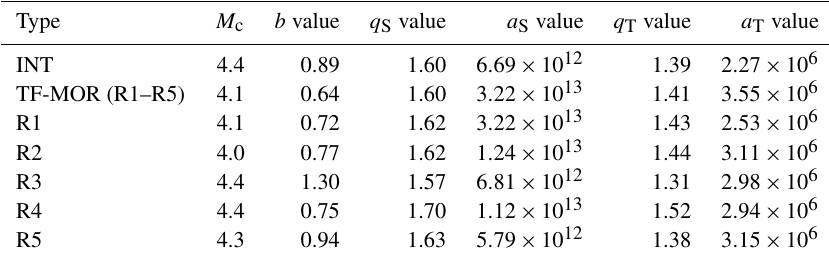
Table 2. Statistical